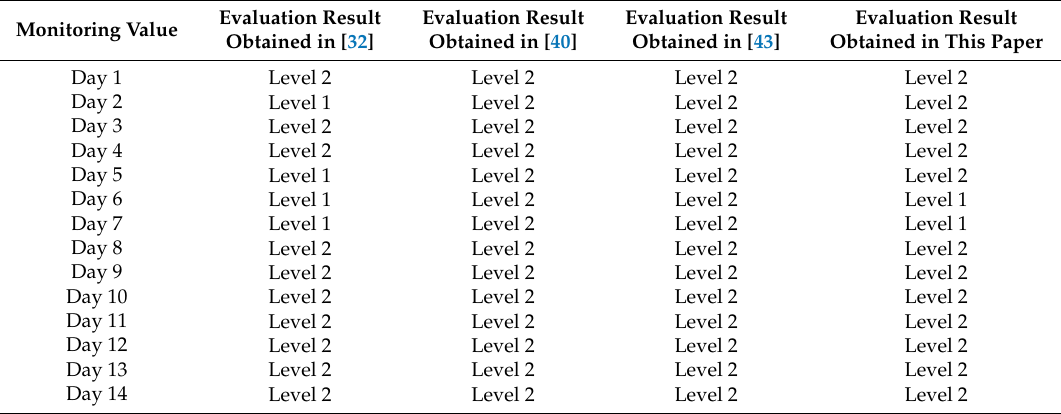
Table 13. The comprehensive power quality evaluation results with different methods.